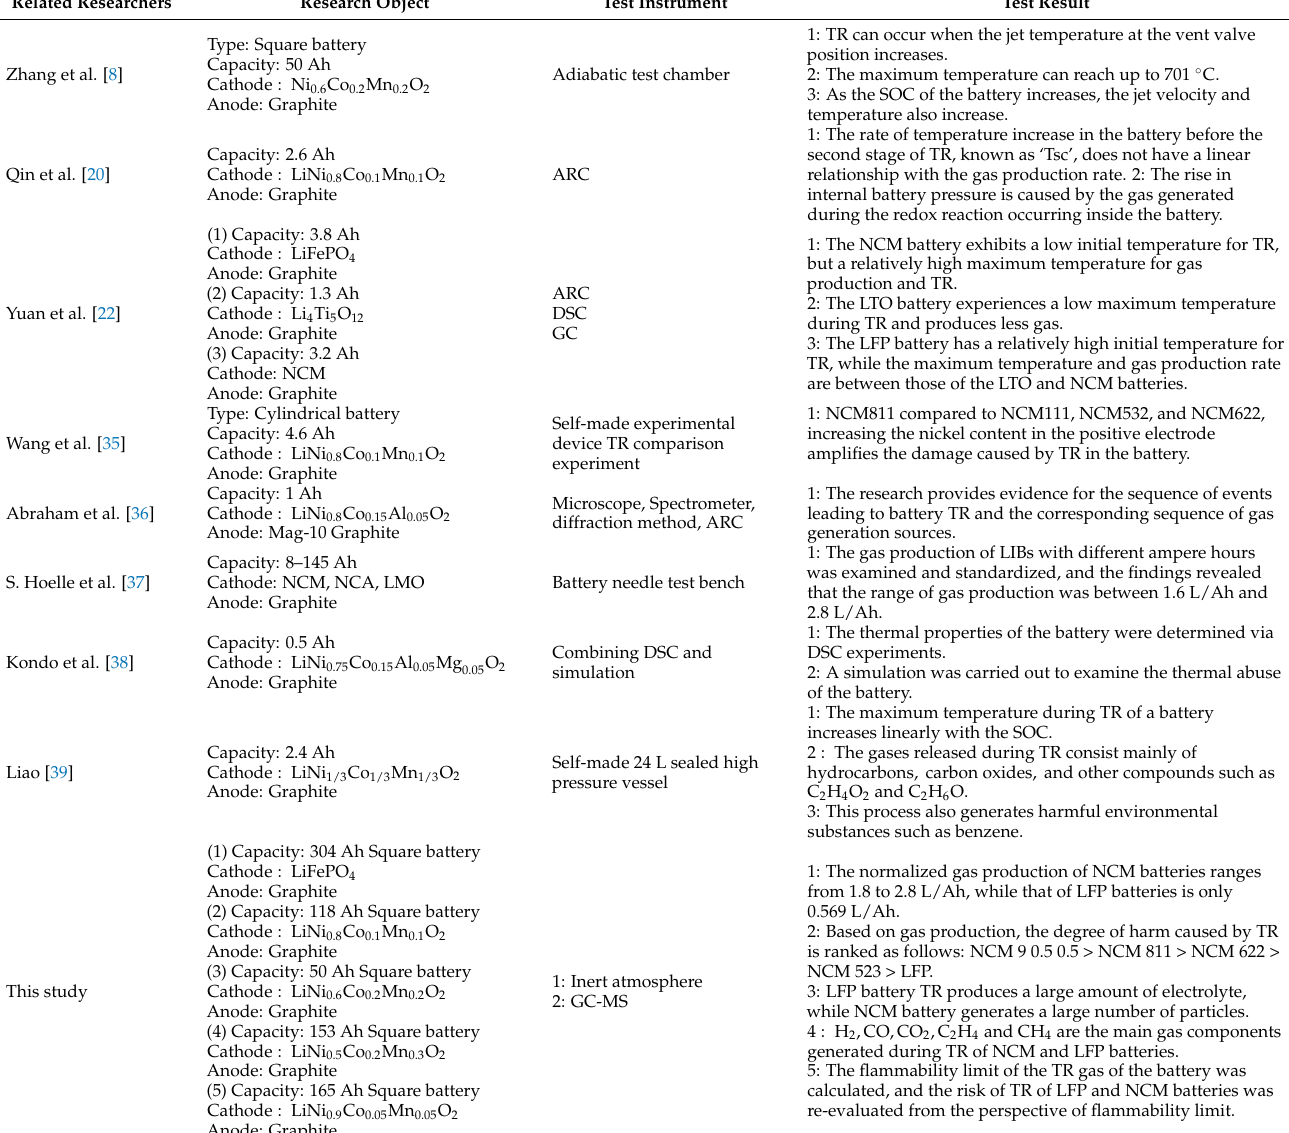
Table 1. Review on TR of lithium ion